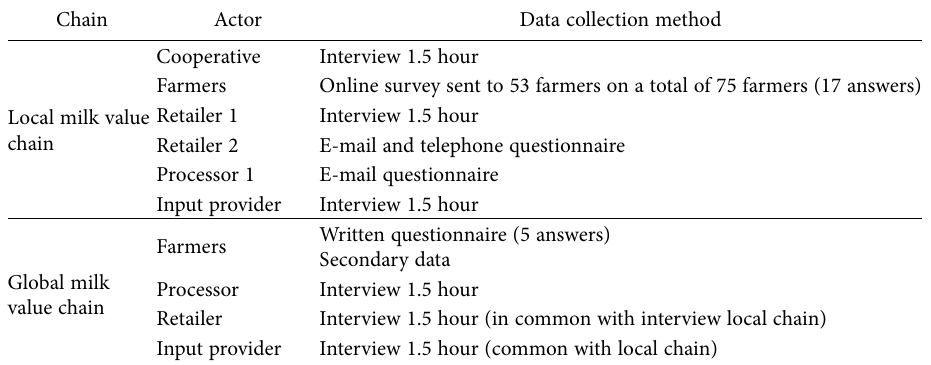
Table 2. Overview of the informing stakeholders and data collection procedures.